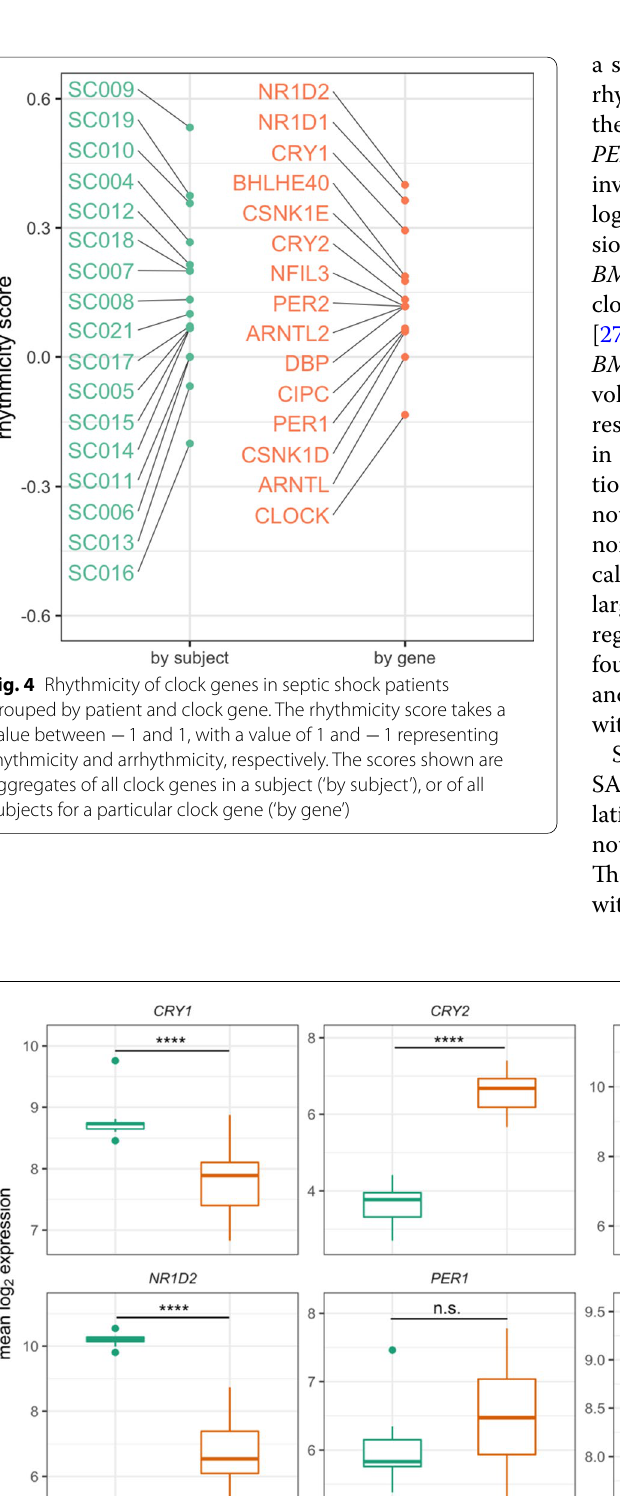
17) in the septic shock patients and healthy young men ( N =